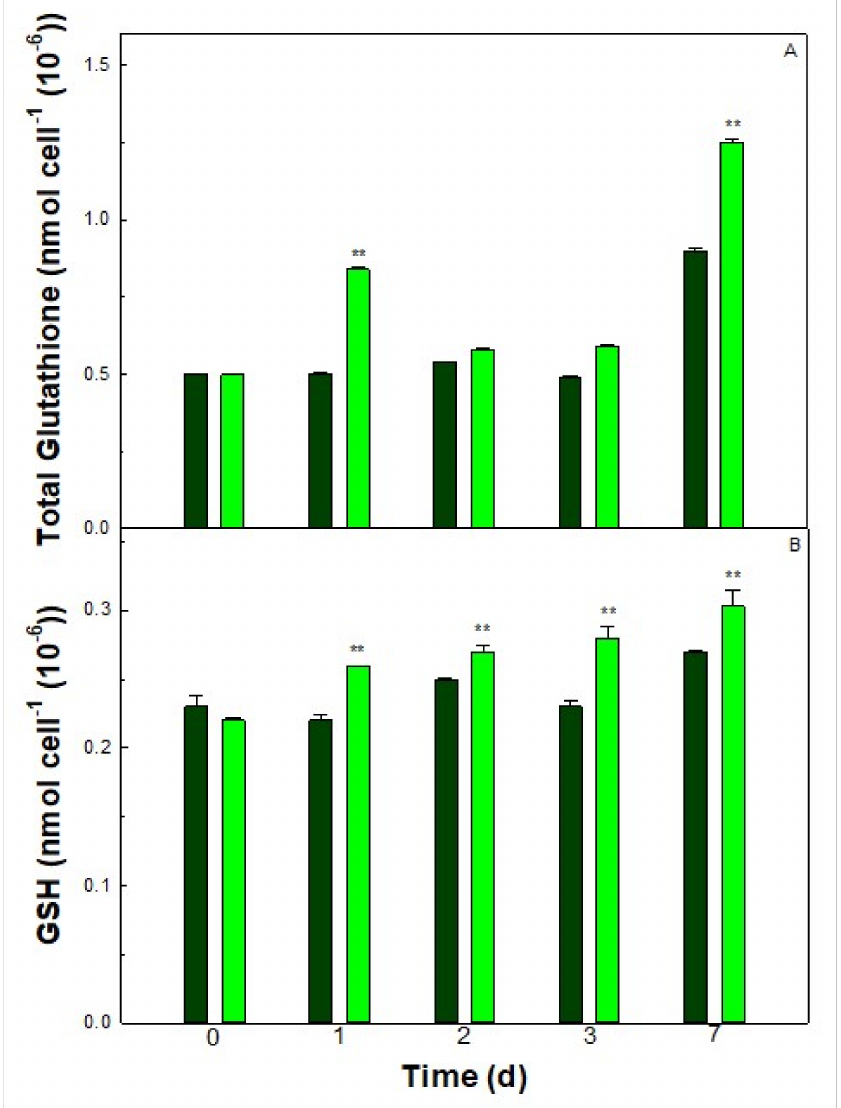
Figure 7. Total ( A ) and reduced ( B ) glutathione in control (dark green) and S starved (-S, light green) cells of Galdieria sulphuraria . Error bars represent SD ( n = 3). Significant differences between control and -S were determined by Tukey HSD test and indicated by asterisks (** p <